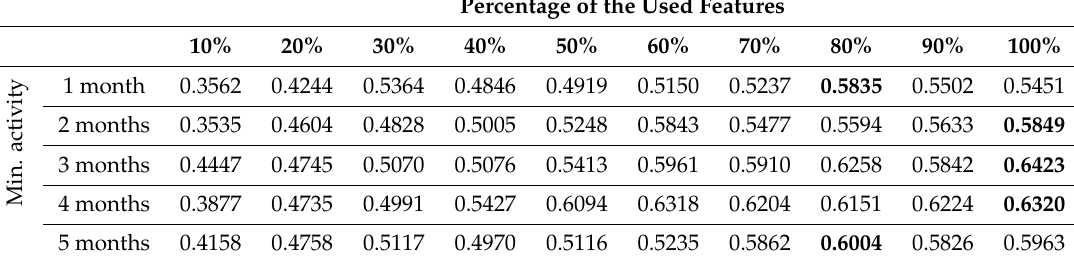
Table A17. F-score macro average for the Random Forest classification of three levels of the hierarchy in the Enron dataset. The values which are bolded are the best results for a given minimum communication activity.